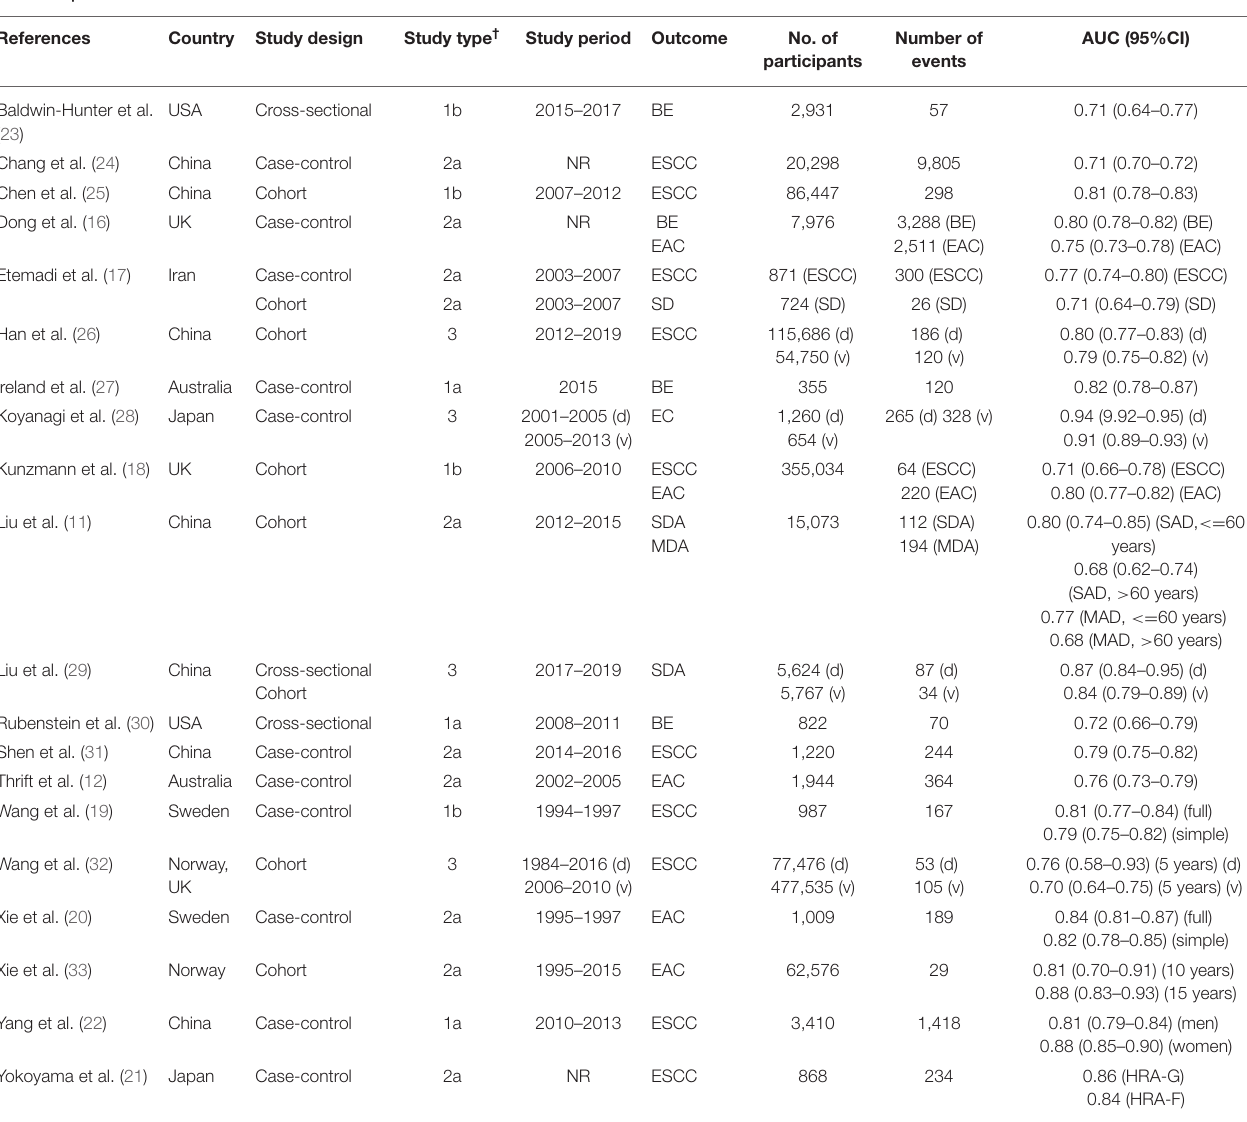
TABLE 1 | Characteristics of included